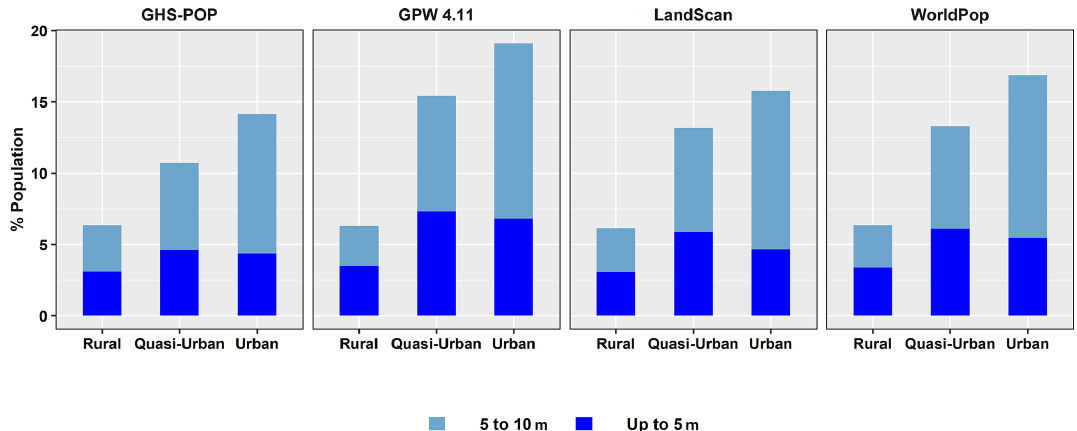
Figure 13. Percentage of the population in each urban class (urban, quasi-urban and rural) in the ≤ 5 and 5–10m LECZ, by each respective urban–rural class, according to different population data sets, 2015. (GHS-SMOD is used for the urban proxy, and MERIT DEM is used for LECZ